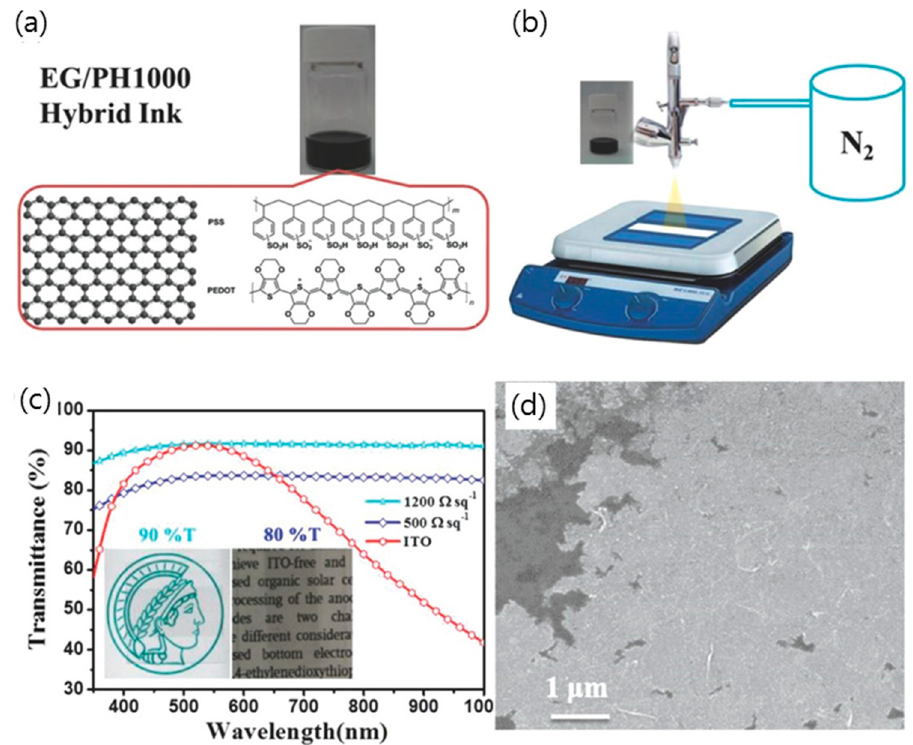
Figure 10. ( a ) Digital image of EG/PH1000 hybrid ink; molecular structures of EG and PH1000. ( b ) Schematic illustration of spray-coating an EG/PH1000 hybrid ink onto desired substrates. ( c ) Transmittance spectrum of both EG/PH1000 hybrid films and ITO on PET substrates. Inset shows the optical images of the EG/PH1000 hybrid films on PET substrates with 90% and 80% transmittance, respectively. ( d ) SEM image of spray-coated EG/PH1000 hybrid film. Reproduced with the permission of Reference [58]. Copyright 2015, Wiley-VCH.